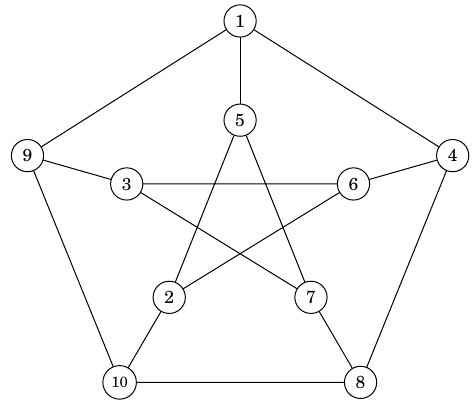
Figure 3: A productive